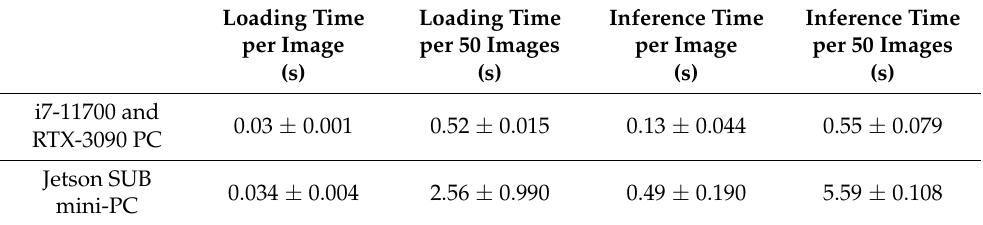
Table 5. Processing time required to load and infer lettuce RGB-D images using an i7-11700 CPU